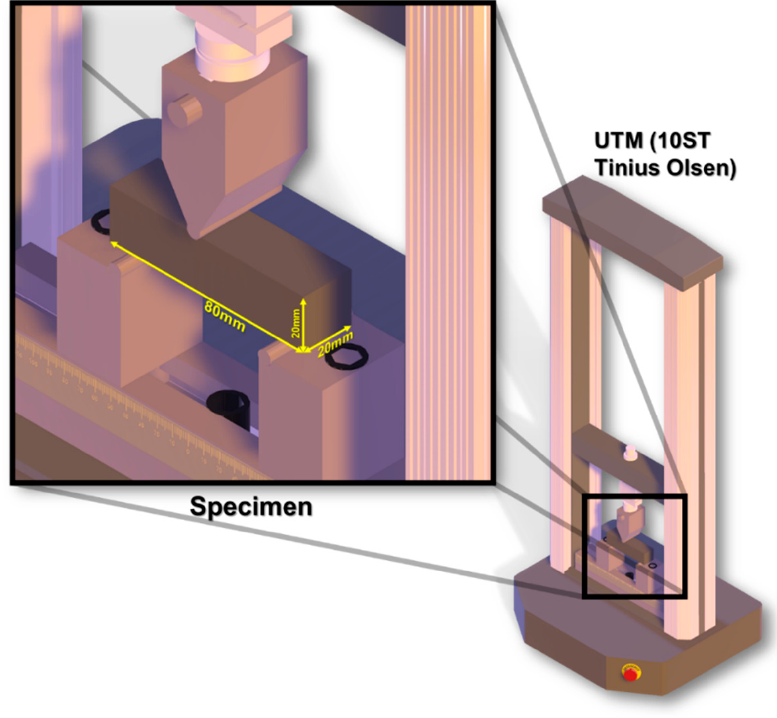
Figure 3. Equipment used for three-point load testing.